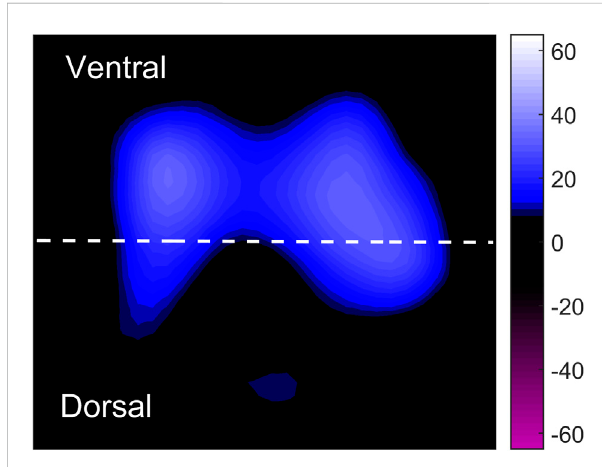
FIGURE 1 Schematicdiagramfor thetidalimpedancevariation oftheentire lung. The whole lung was divided into ventral and dorsal equally, with dotted lines as the dividing line. Low ventilation area and high ventilation area are marked with dark blue and light blue, respectively. Tidal impedance variations at different phases are marked in purple.